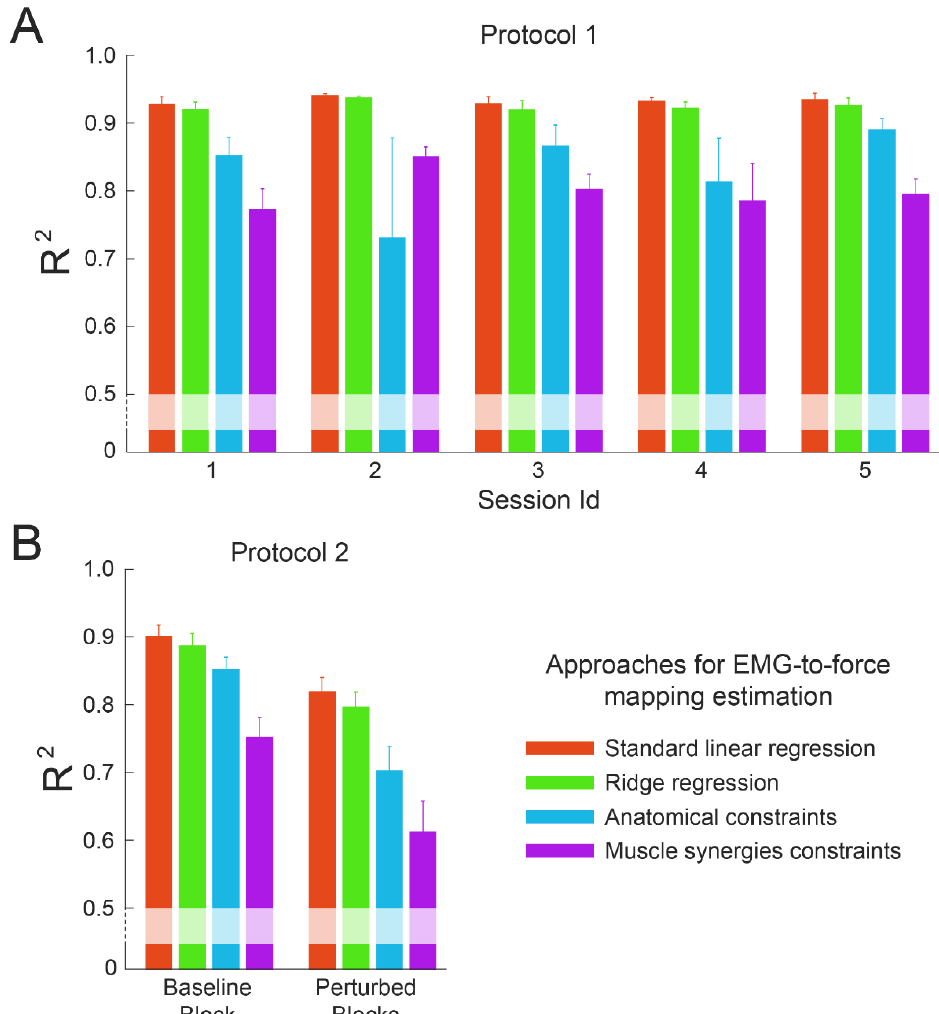
Figure 5. Results of the within-dataset fitting. Coefficients of determination ( R 2 ) calculated by fitting a dataset collected during protocol 1 (panel A ) or protocol 2 (panel B ) with an EMG-to-force mapping extracted from the same dataset. Each bar represented the coefficients of determination obtained by using different approaches to fit data (color-coded, mean ± standard error (SE) across participants).